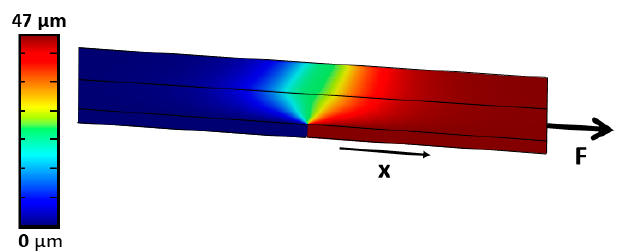
Figure 4. Finite element simulation of a viscoelastic material (retina) on top of two adjacent titanium plates. While the left plate is fixed with position constrains, a loading force of 1.0 mN in x-direction is acting onto the right sidewall of the right titanium plate, resulting in a displacement in x-direction of 47 µm for a chosen retinal Young’s modulus of 760 Pa. The displacement in x-direction is color-coded from blue (no displacement) to red (maximum displacement). It can be seen that the retina material is only stretched – viz. a shear deformation is visible – close to the gap where the two scaffold materials are pulled apart. At all other positions the retina is strongly attached to the scaffolds and moves according to the underlying substrate.